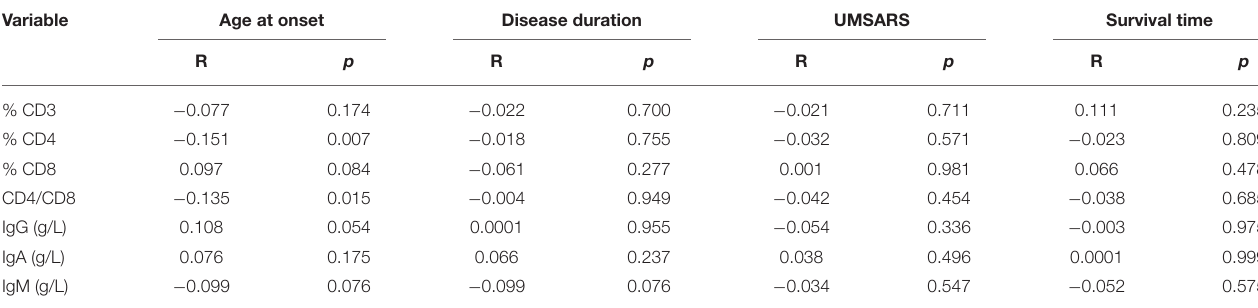
TABLE 3 | Spearman correlations of clinical characteristics with PIA variables of MSA patients. Variable Age at onset Disease duration UMSARS Survival